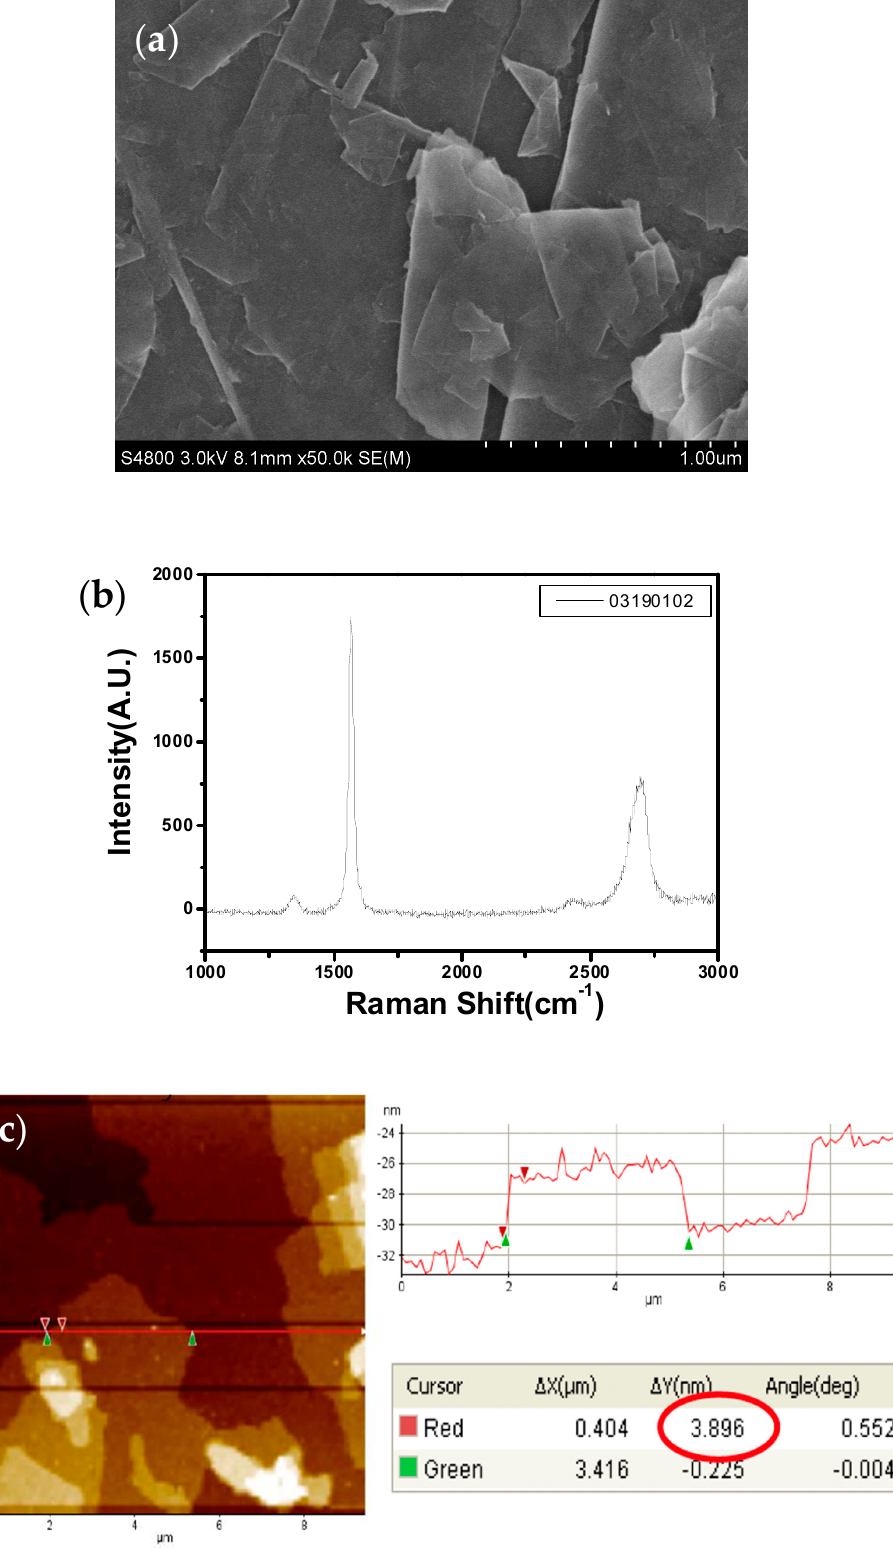
Figure 3. The characteristics of graphene nanoparticles. ( a ) SEM image; ( b ) Raman spectrum; ( c ) AFM image.